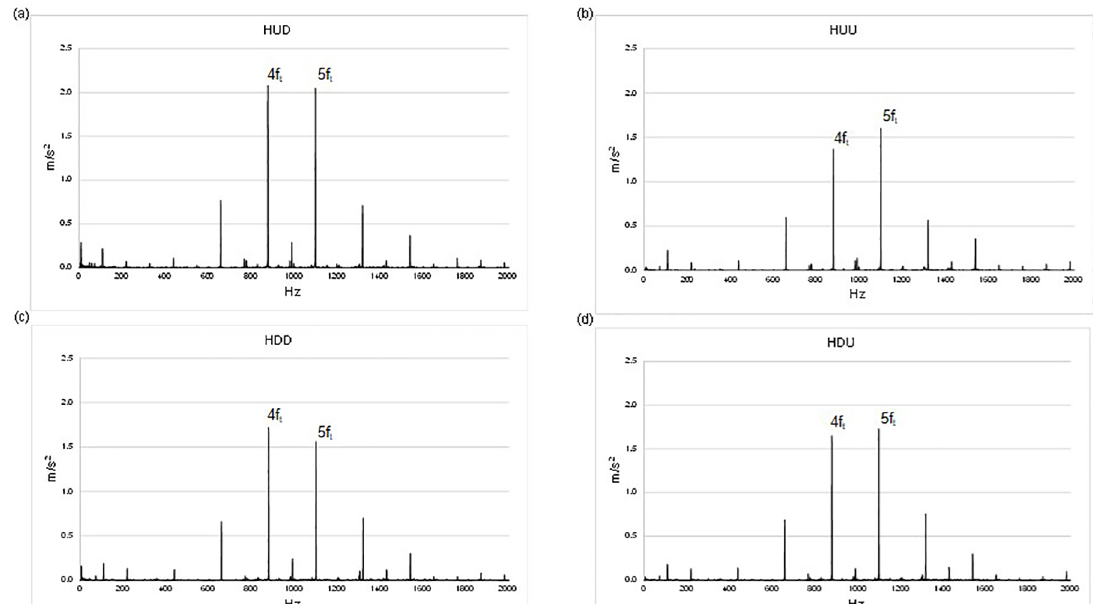
Figure 10. Spectrum of the acceleration signals for horizontal tool path orientations at inclined workpiece angle of 75º (a) HUD, (b) HUU, (c) HDD, (d)